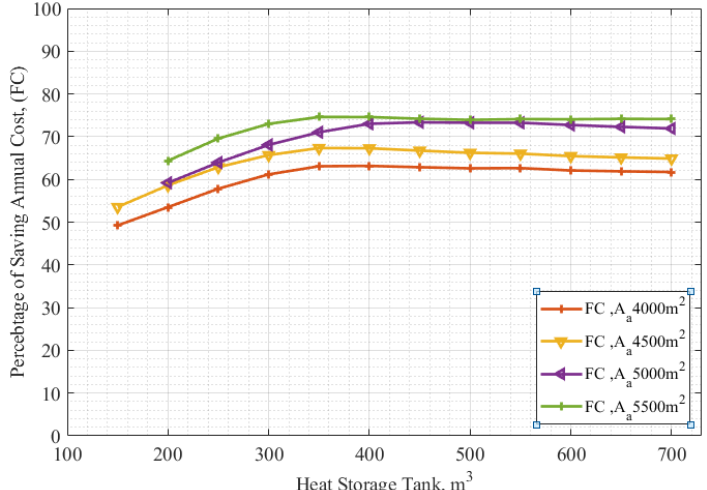
Figure 17. Savings of the annual operating cost of ADC unit vs VCC unit for the storage tank size and different solar field sizes for an auxiliary set point temperature of 70 ◦